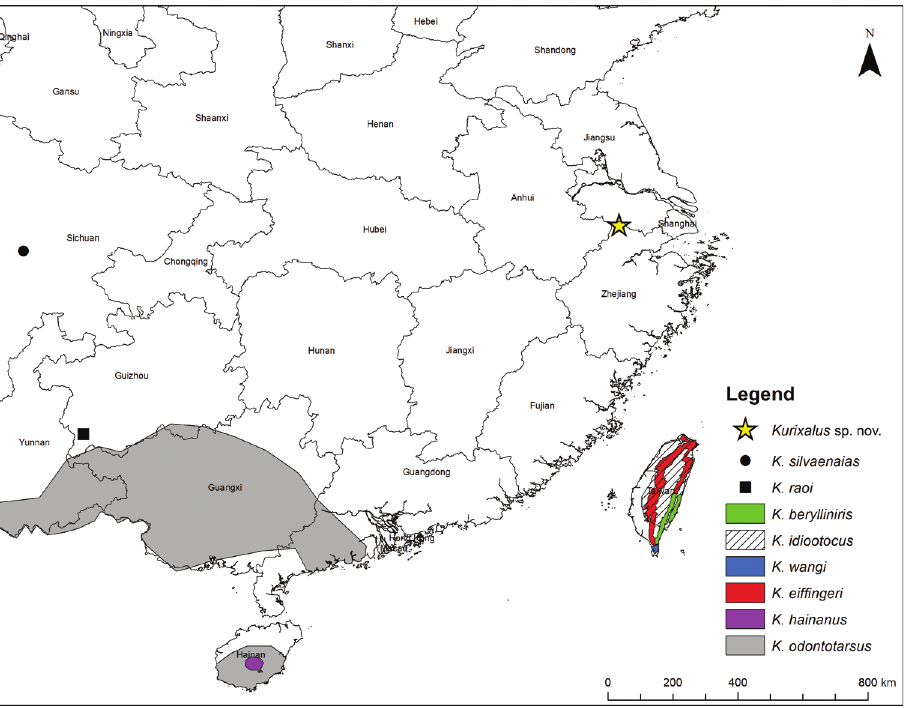
Figure 1. Map of sampling site and Kurixalus species. The sample for Kurixalus sp. nov. were collected in April and July 2018 in north-western Zhejiang Province, People’s Republic of China. Map generated in ArcMap